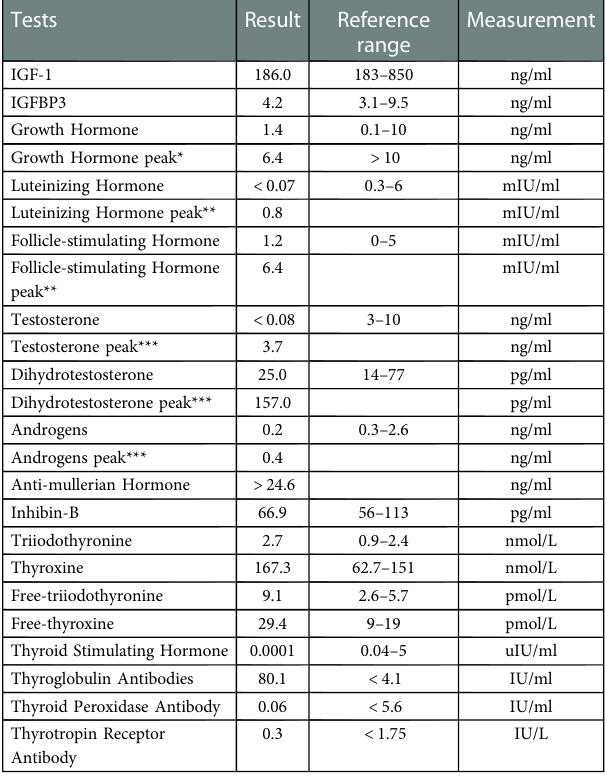
TABLE 1 Endocrine hormones of the